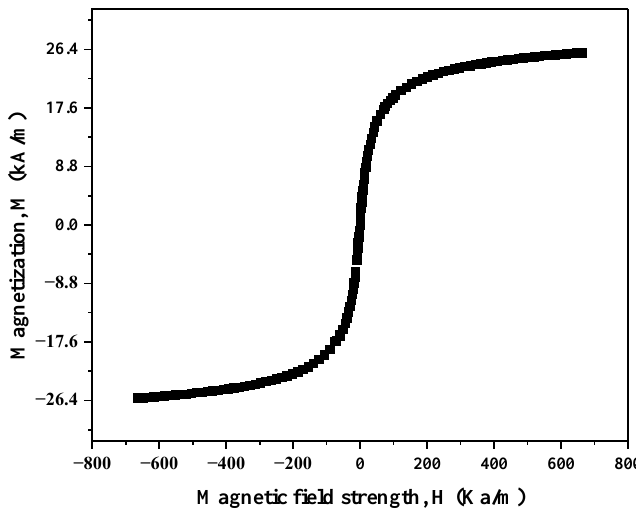
Figure 2. Magnetization curve of ferrofluid. Table 2. Physical parameters of L-AN32-based